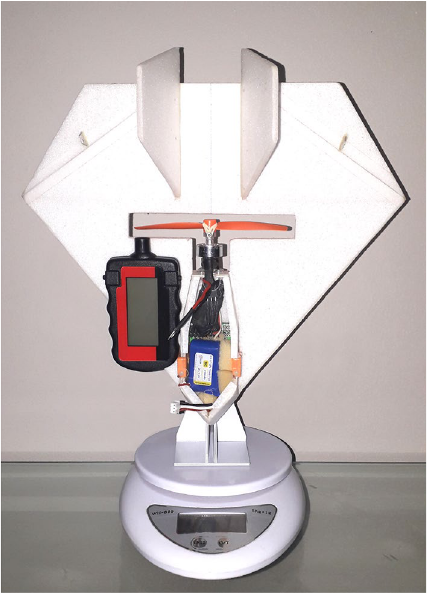
Figure 24. Digital scale with high-precision and digital spin counter HCAP0400 used for static thrust determination.